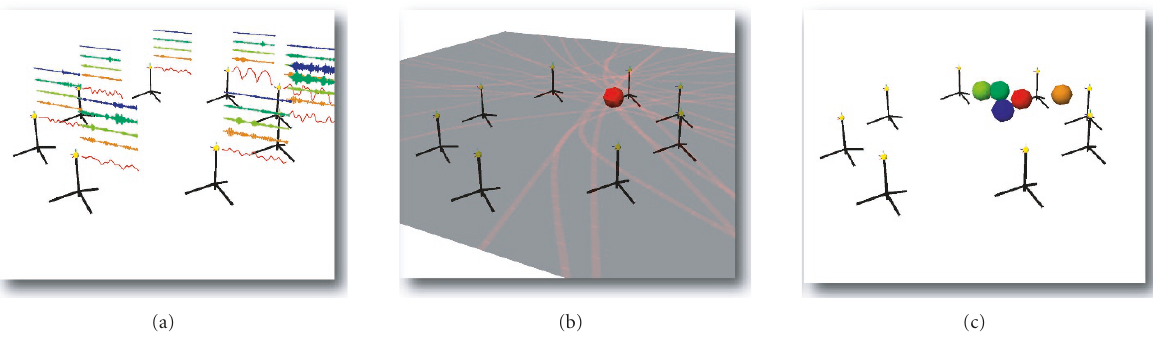
Figure 5: Illustration of the construction of the global spatial mapping for the captured sound-field. (a) At each time frame, we split the signals recorded by each microphone into the same set of frequency subbands. (b) Based on time-di ff erence of arrival estimation between all pairs of recordings, we sample all corresponding hyperbolic loci to obtain a position estimate for the considered subband. (c) Position estimates for all subbands at the considered time frame (shown as colored